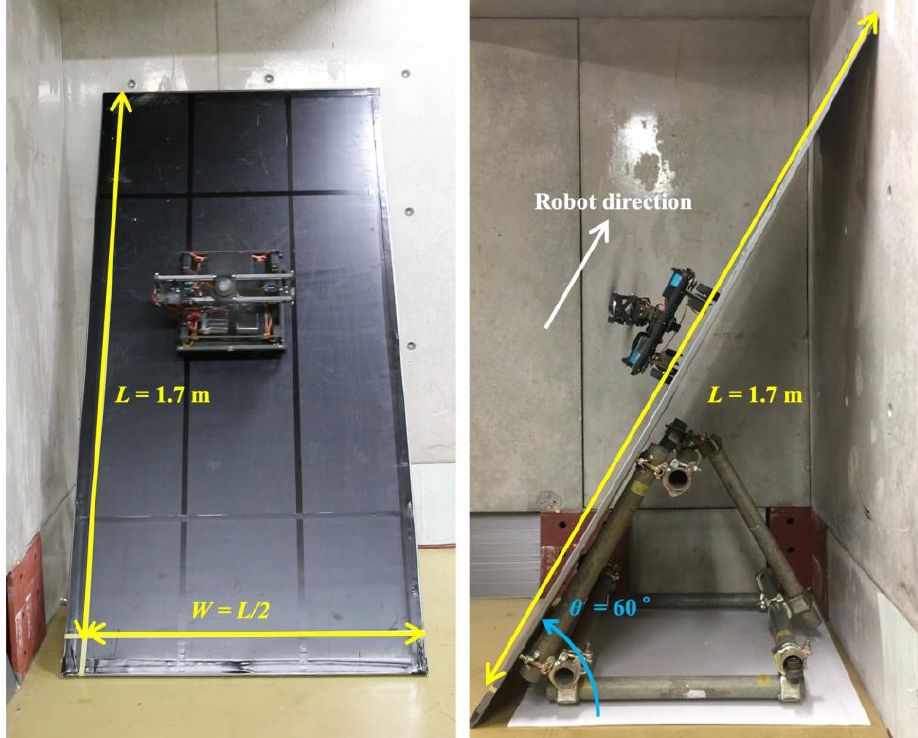
Figure 10. Experimental setting for the measurement of the covered area (( left ) from front, ( right ) from side).